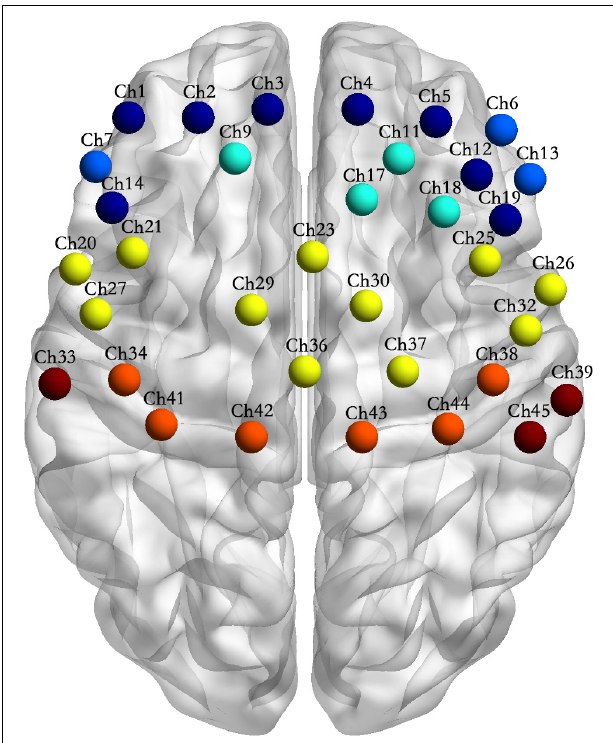
FIGURE 4 | Channel location of the interactions between motor tasks and subject groups. Note: Channel sites of the same color in the figure represent that they are from the same Brodmann area